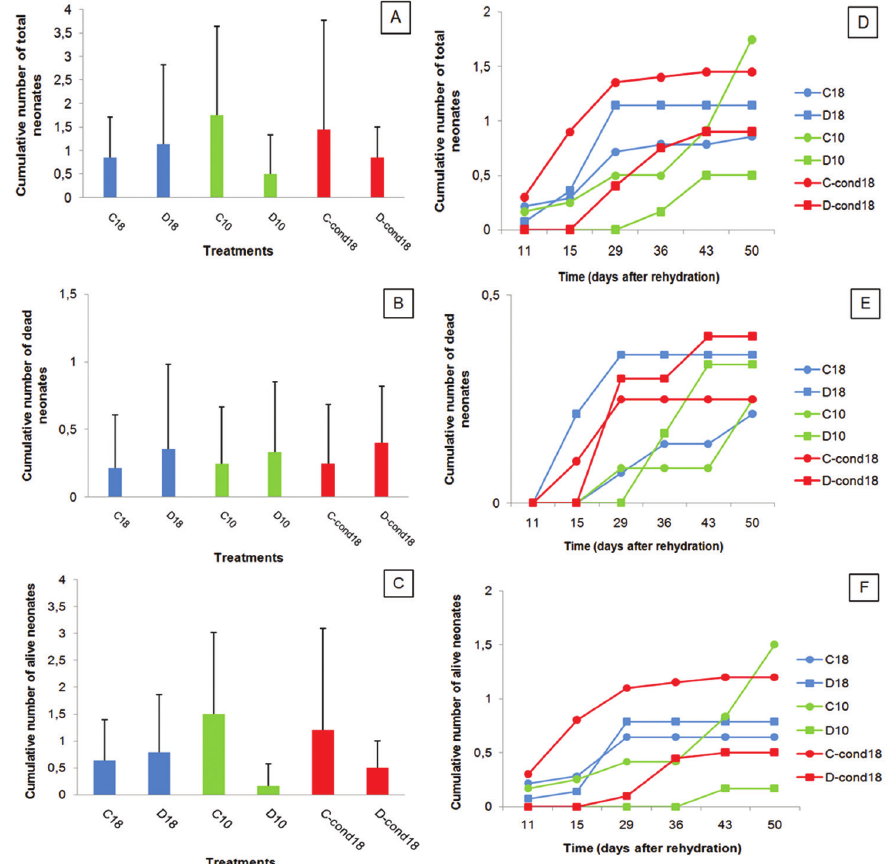
Figure 5. Mean (+ SD) of the cumulative number of total neonates ( A ) , dead neonates ( B ) and live neonates ( C ) registered at day 50 after rehydration ( n = 6 observations). No significant differences were found between treatments ( p > 0.01; Mann-Whitney U test and Kruskal-Wallis test). Mean (SD has been removed for clarity) of the cumulative number per observation time of total neonates ( D ) , dead neonates ( E ) and live neonates ( F ) registered between 8 and 50 days after rehydration ( n = 6